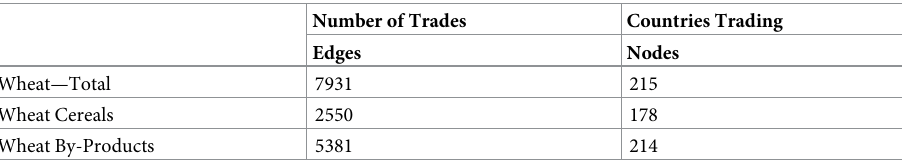
Table 3. Summary descriptive of global wheat